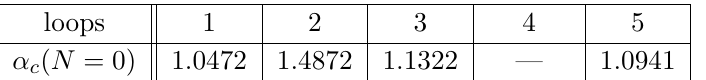
Table 1 : Critical couplings of quenched QED symbol “—” indicates that no physical solution is